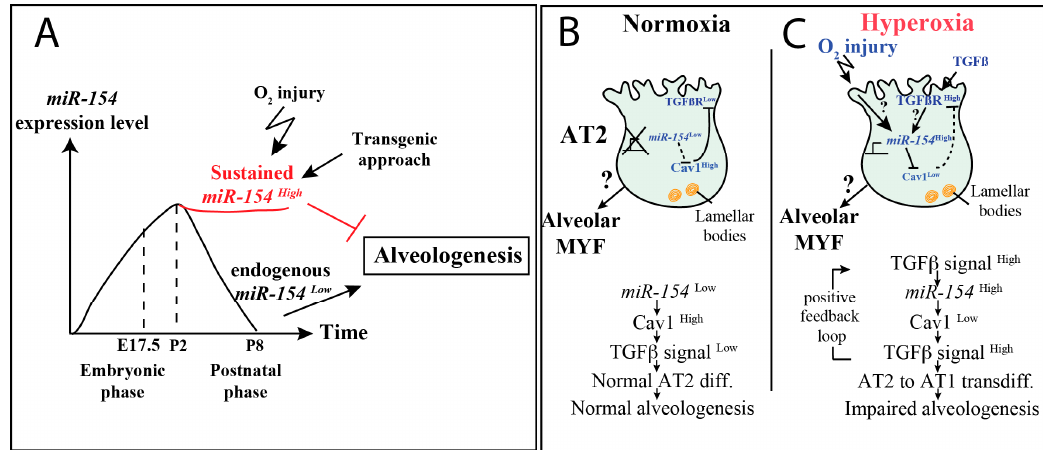
Figure 8. Hypothetical Model of Action describing miR-154 function in lung development. A. miR-154 expression level alterations during embryonic and postnatal phases. Postnatal miR-154 decrease allows proper alveologenesis, whereas hyperoxia-induced sustained miR-154 levels lead to the disturbance of alveologenesis. B. Under normoxic conditions postnatal miR-154 repression occurs to enable Cav1 to inhibit Tgf- β signaling by Tgf- β r1 internalization leading to proper alveologenesis in postnatal development. C. Hyperoxia leads to miR-154 induction and subsequent repression of Cav1-mediated Tgf- β r1 internalization. Tgf- β signaling is unleashed disturbing alveologenesis.